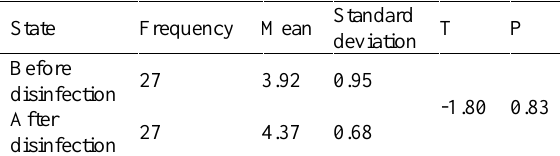
Table 5. Number of samples before and after disinfection based on colony count Frequency of Frequency of Colony count samples before samples Disinfection